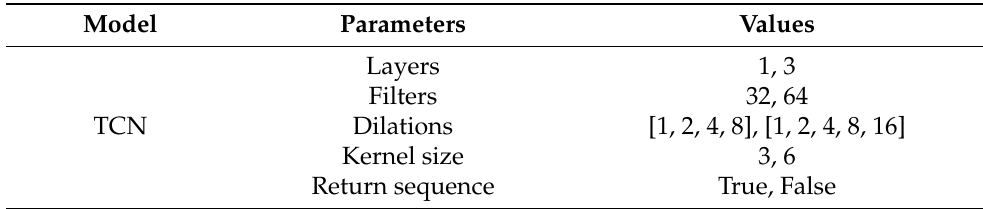
Table 4. Grid of parameters used for TCN models.